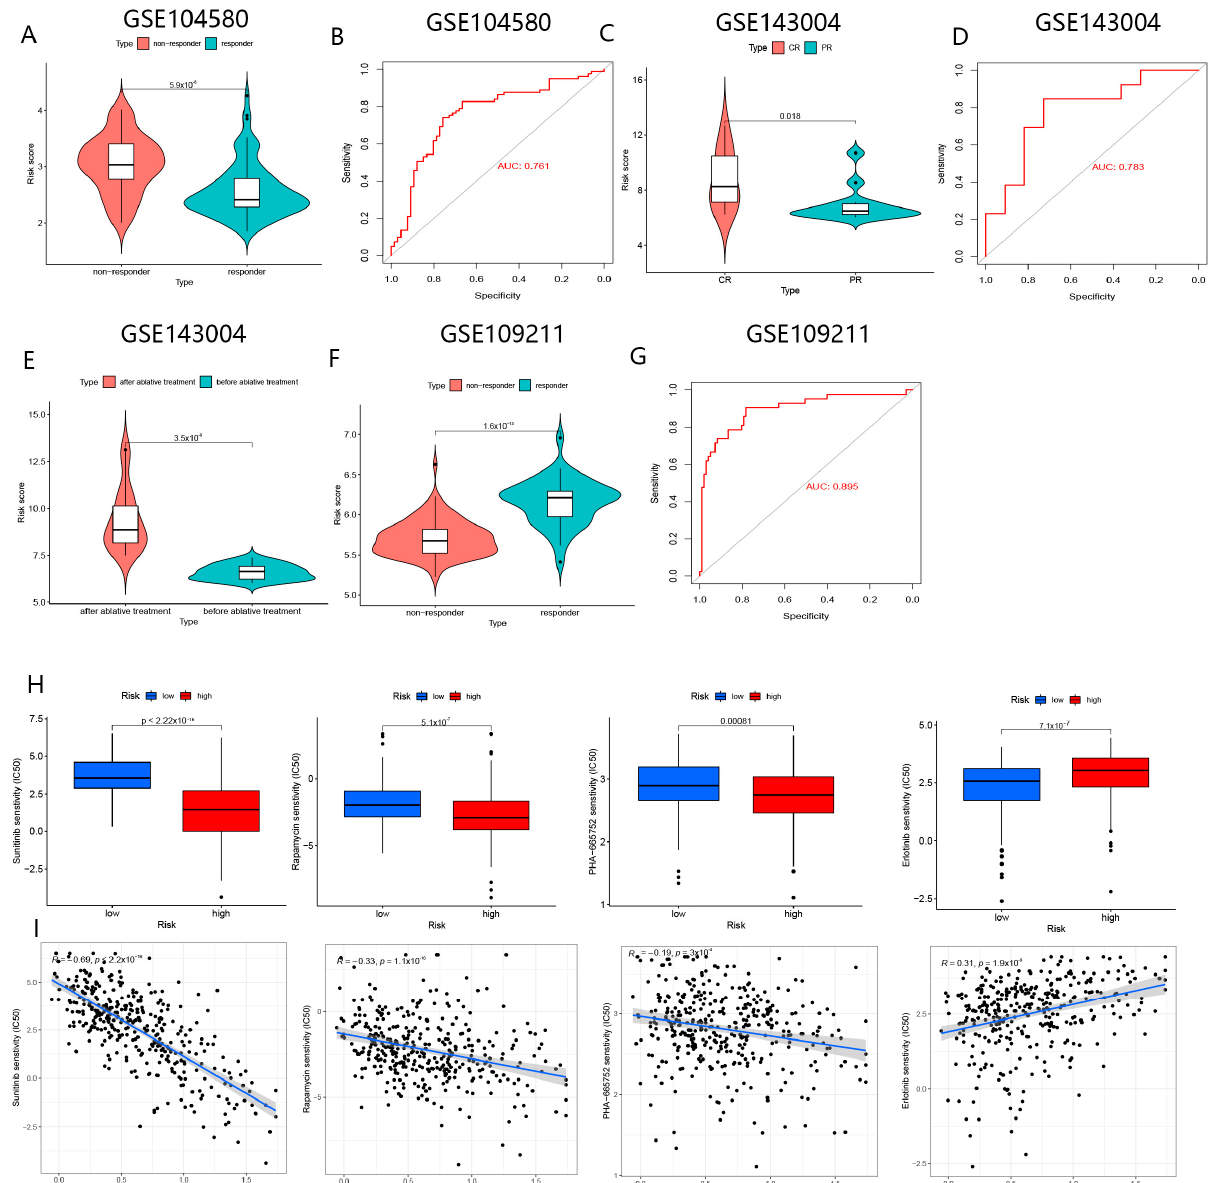
Figure 15. The role of BMGs for the prediction of responses to TACE and ablation therapy. ( A ) Comparison of risk scores in responders and non-responders to TACE. ( B ) The ROC of risk scores for assessing the responses to TACE. ( C ) Comparison of risk scores in CR and PR to ablation therapy. ( D ) The ROC of risk scores for assessing the responses to ablation therapy. ( E ) Comparison of risk scores before and after ablation treatment. ( F ) Comparison of risk scores in responders and non-responders to “sorafila” in GSE109211. ( G ) The ROC of risk scores for assessing the responses to “sorafila” in the GSE109211 cohort. ( H ) Comparison of IC50 of drugs in high- and low-risk groups. ( I ) The correlation of risk score with IC50 of drugs.